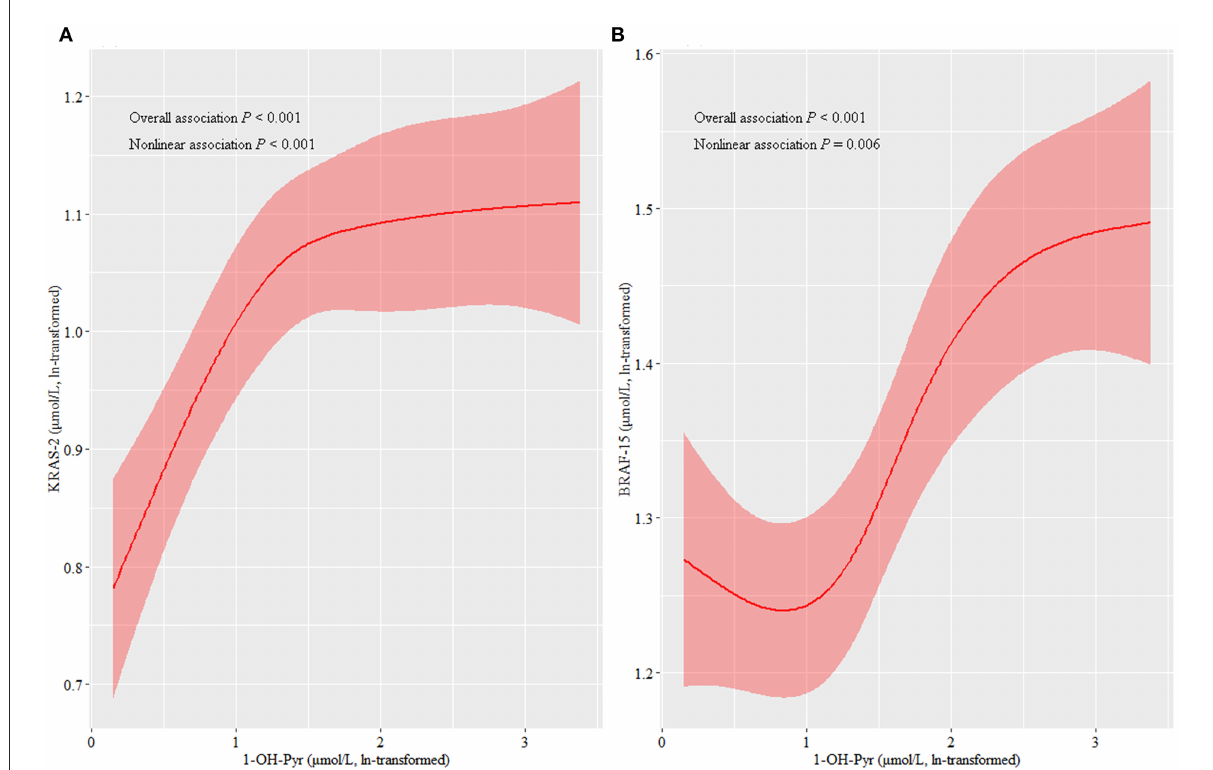
FIGURE1 The associations of urinary 1-OH-Pyr with KRAS-2 and BRAF-15 based on the restricted cubic spline function using a smooth 5 default knots (5th, 27.5th, 50th, 72.5th, and 95th percentiles).